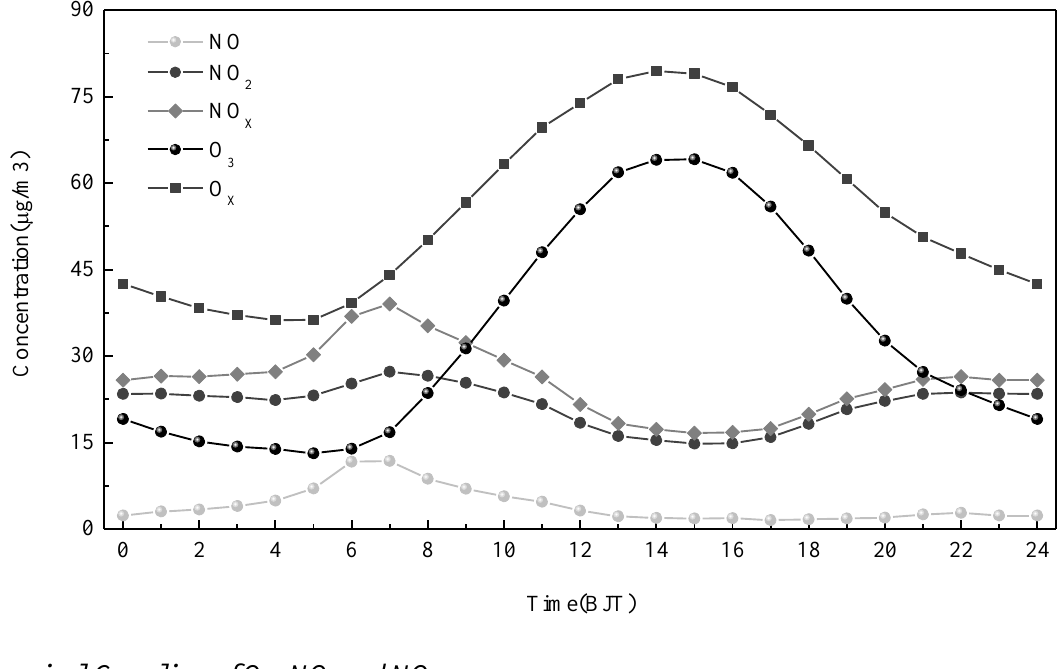
Figure 2. Daily variation of mean concentrations of O summertime in